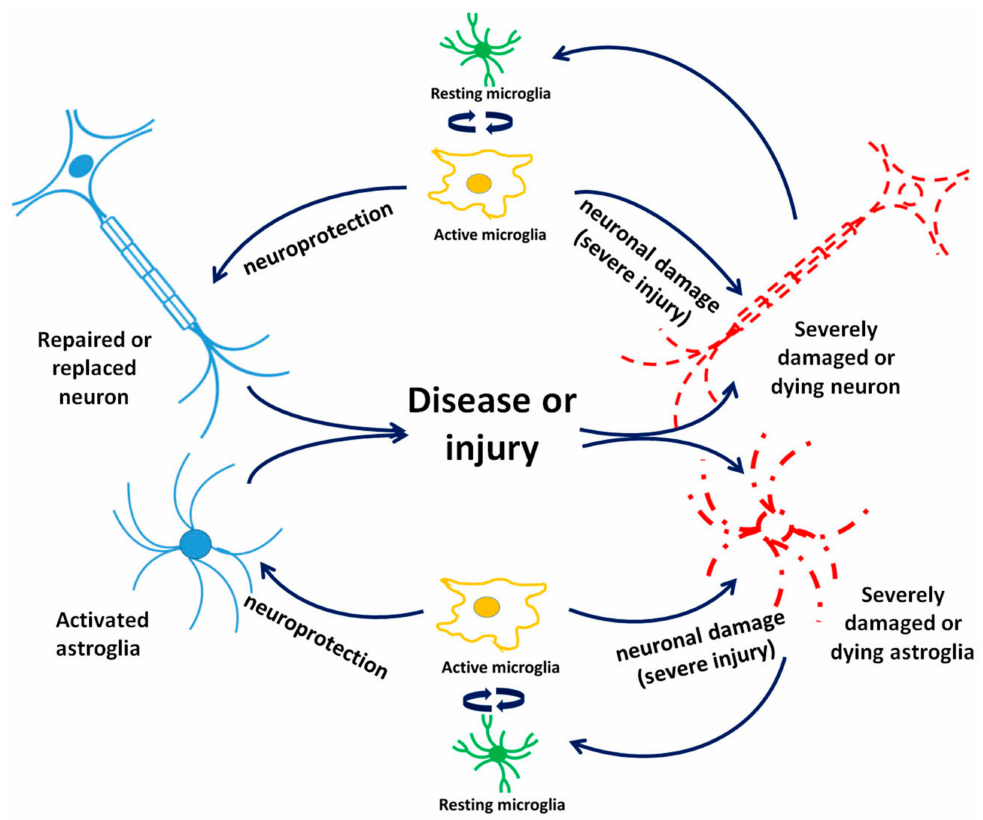
Figure 2. Interactions between brain cell types taking part in acute and progressing brain damage after brain injury and disease. Acute microglial activation following mild brain damage causes may provide protection to neurons and astrocytes while long-term glial activation may cause damage to and the death of neurons and